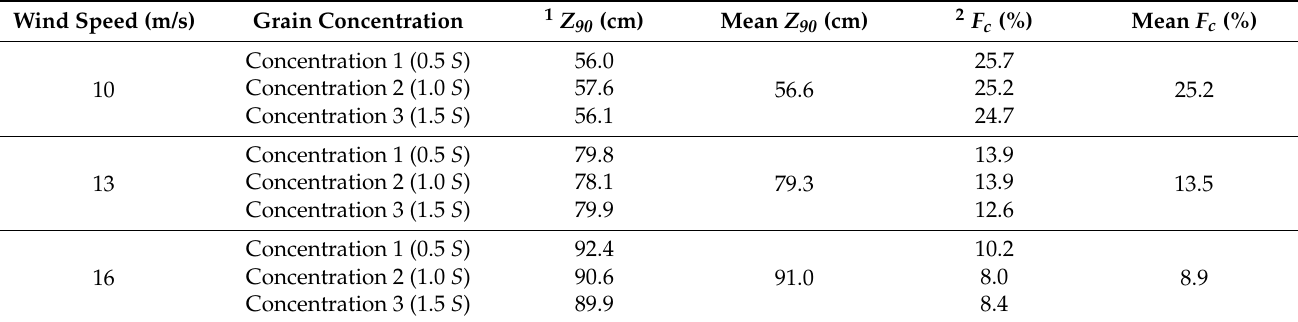
Figure 4. Cumulative mass percentage: ( a ) At the test wind speed of 10 m/s; ( b ) At the test wind speed of 13 m/s; ( c ) At the test wind speed of 16 m/s. Table 1. Some characteristic parameters of moving